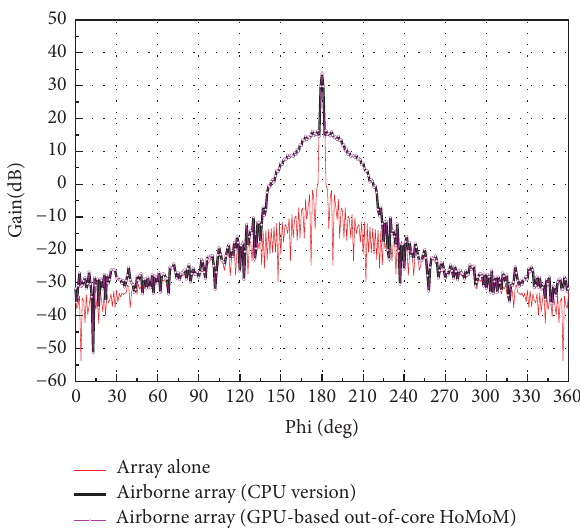
Figure 20: 2D results of the airborne wire antenna array in xoy